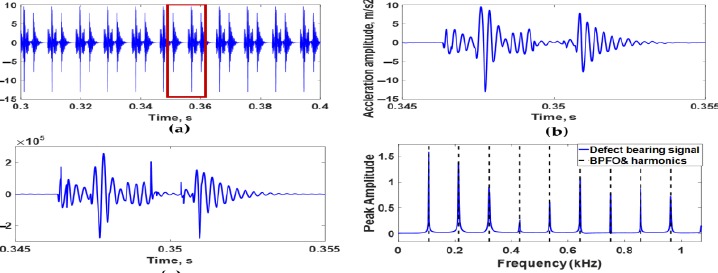
Figure 14. ( a ) Simulated acceleration signal of bearing with 7 random defects (bump and dent) on its outer race, ( b ) enlarged simulated acceleration signal between 0.345 s and 0.355 s, ( c ) simulated jerk signal, and ( d ) envelope spectrum of simulated acceleration signal.